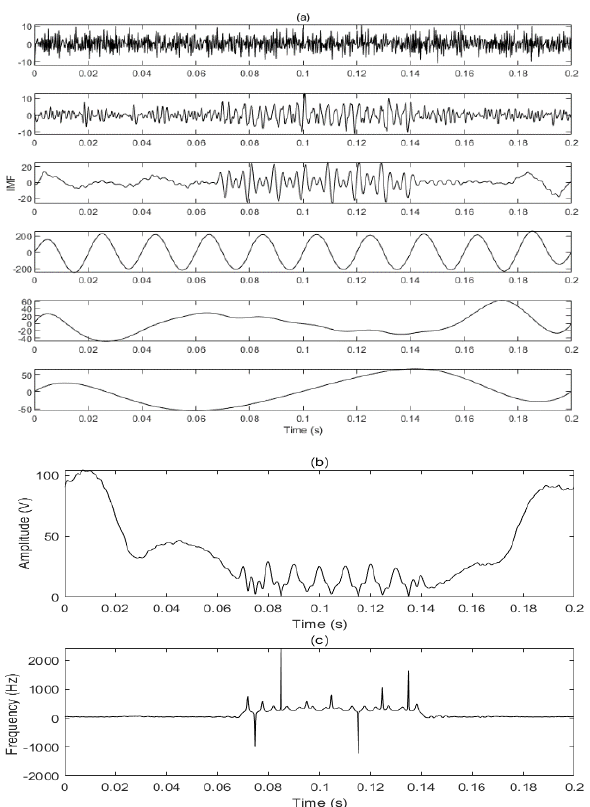
Figure 13. Impulsive transient IMF components ( a ), amplitude ( b ), and frequency ( c ).